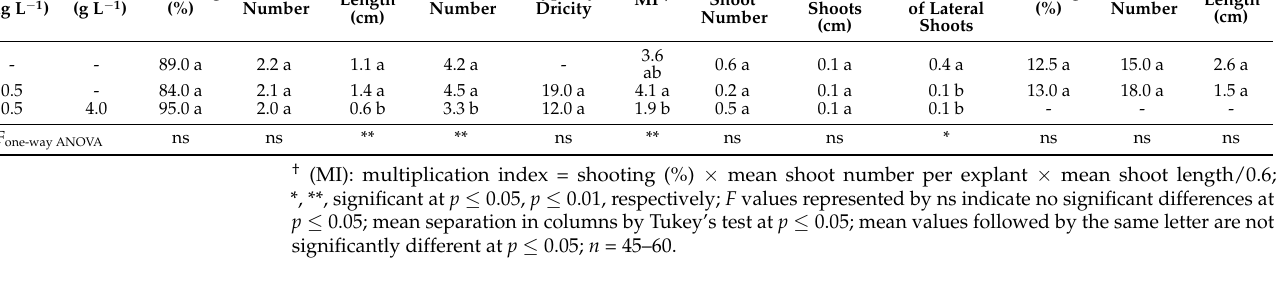
Figure 4. Forty-day-old young seedlings of Sideritis raeseri subsp. attica grown in vitro on half- strength MS media without any hormones (MS/2) ( A ) before and ( B ) during the subculture. Bars represent a length of 1.0 cm. Table 2. Establishment stage: initial cultures of node explants excised from in vitro-grown, young seedlings of Sideritis raeseri subsp. attica on MS media without hormones (Hf) or supplemented with 6-benzyladenine (BA) at 0.5 mg L − 1 , with or without polyvinylpyrrolidone (PVP) at 4.0 mg L − 1